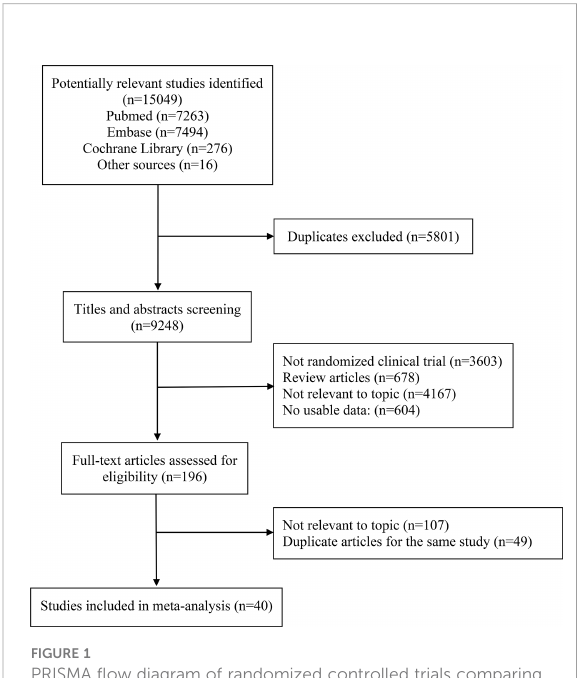
FIGURE 1 PRISMA fl ow diagram of randomized controlled trials comparing immune checkpoint inhibitors with